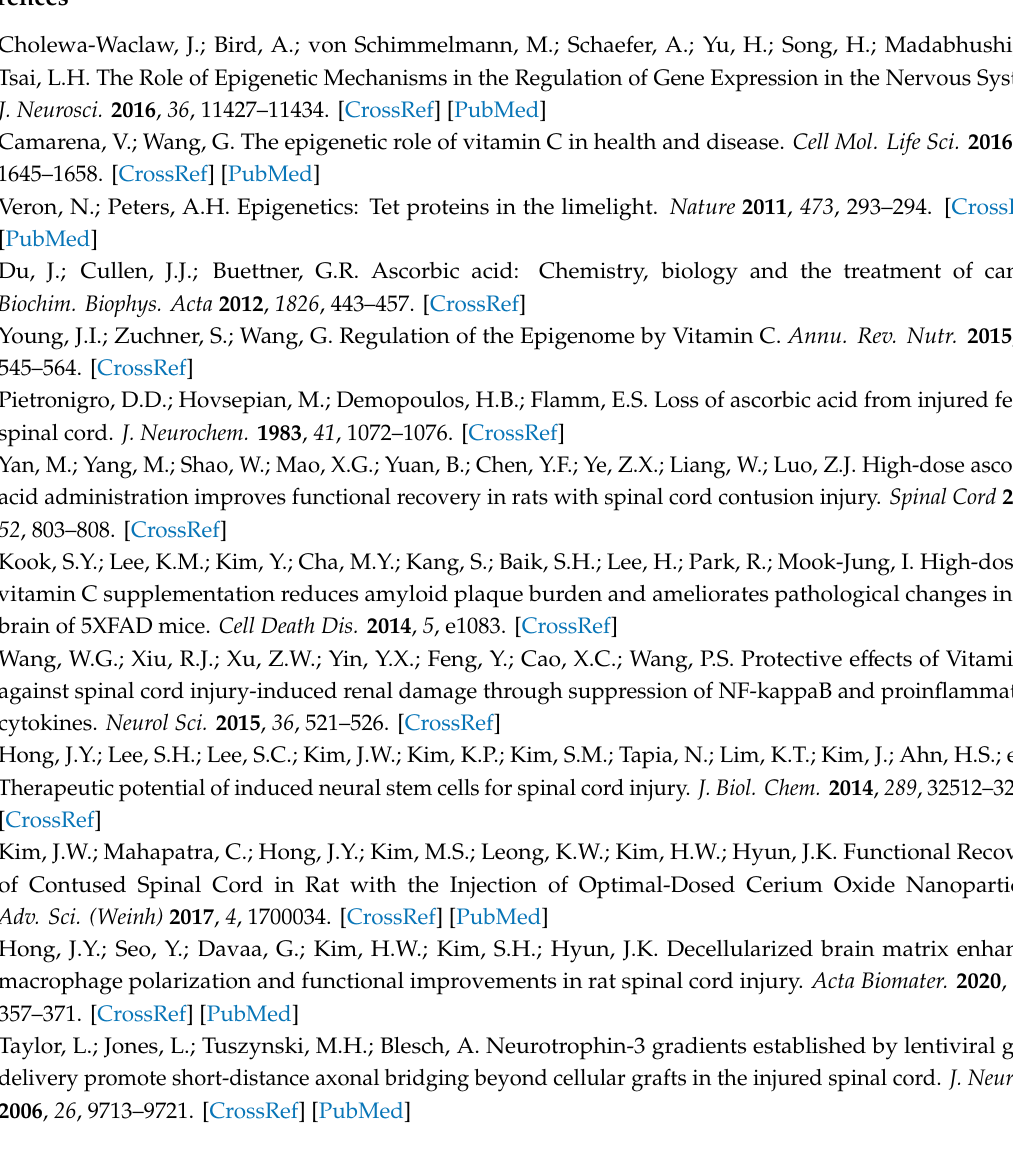
Figure S1: Quantitative data from dot blot analysis of 500 and 100 ng of DNA for 5hmC and 5mC, Figure S2: DAB staining analysis of NF200 in the injured spinal cord tissue 12 w after injury, Figure S3: Distribution of Tet1 genes within neurons, astrocytes, and oligodendrocytes in the brain motor cortex 12 week after